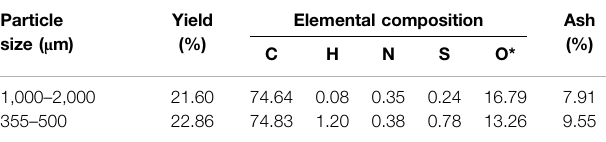
TABLE 5 | Effect of particle size to the elemental composition of bamboo chars. Particle size ( μ